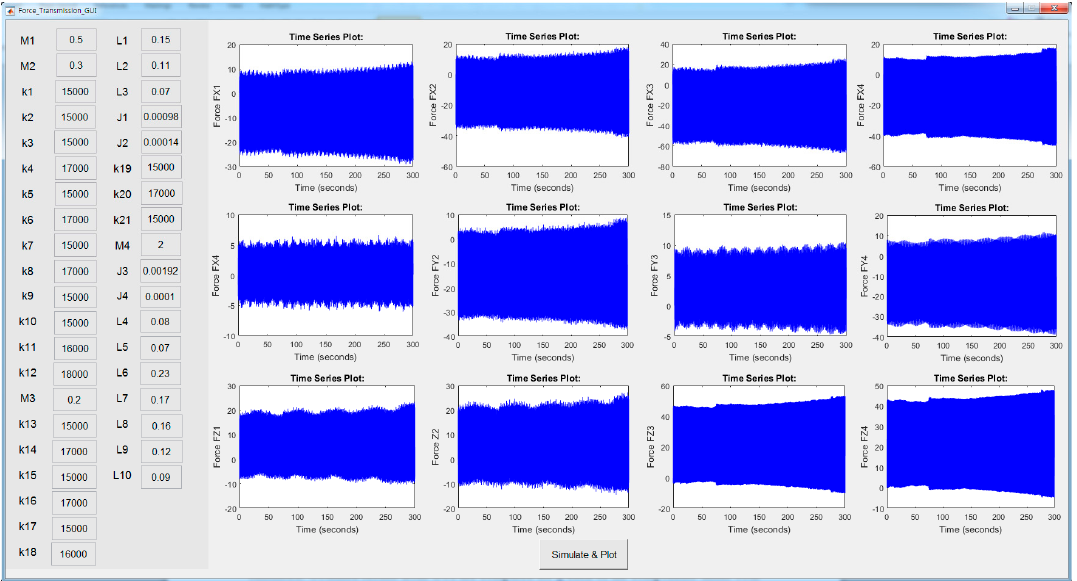
Figure 10. Demonstration of the developed graphical user interface (GUI).